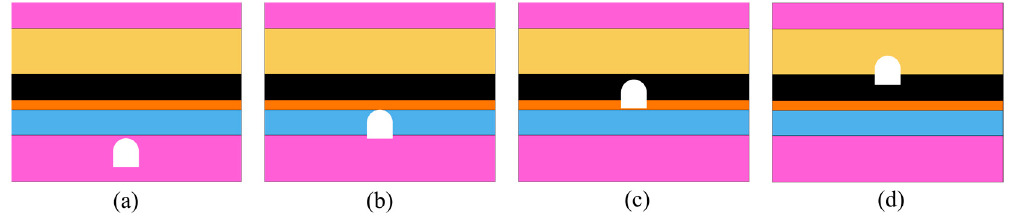
Figure 5. Four rock strata: ( a ) Case 1; ( b ) Case 2; ( c ) Case 3; ( d ) Case